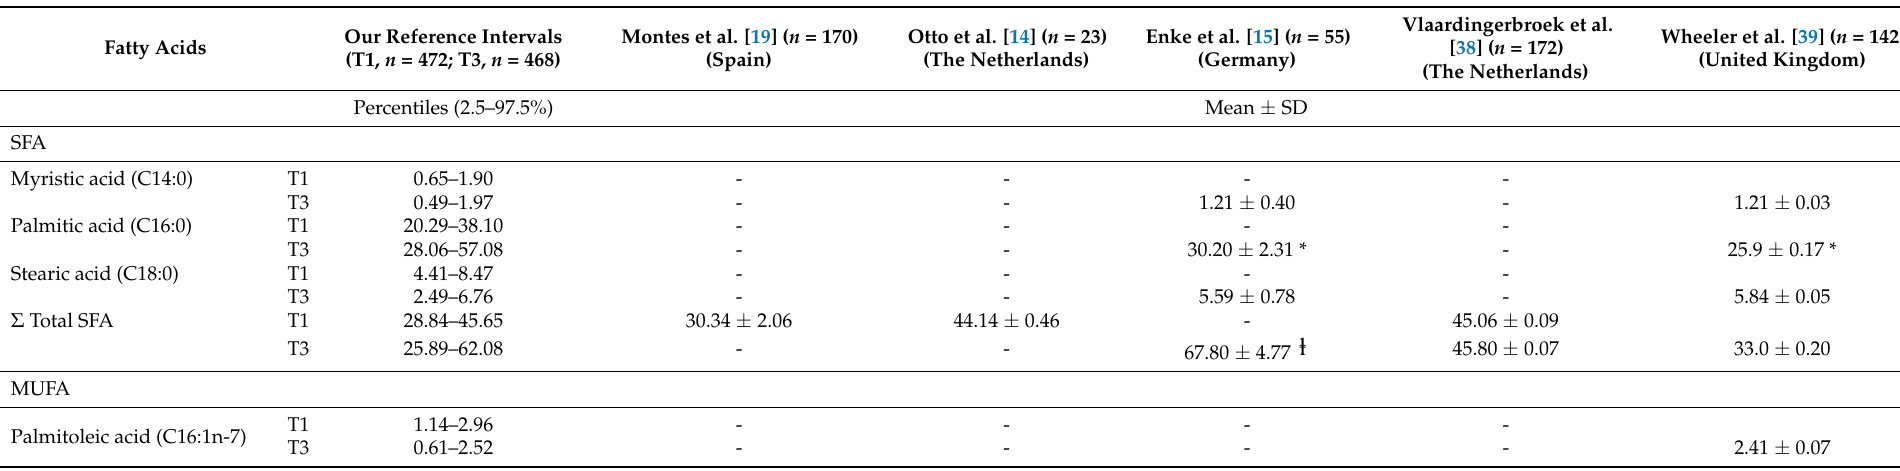
Table 4. A comparison of reported concentrations (%) of total fatty acids in maternal serum from different European